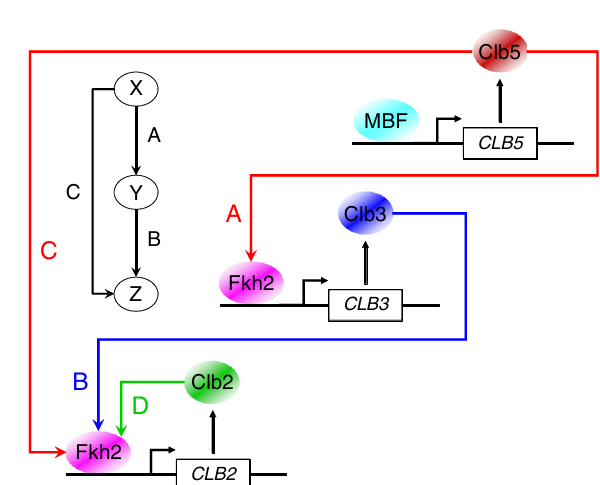
Fig. 6 Model for the transcriptional regulation of the mitotic Clb cascade. A coherent type 1 feed-forward loop may activate CLB genes. Our data indicate a linear activation of Clb cyclins via the Fkh2 transcription factor: Clb5/Cdk1 promotes CLB3 transcription ( arrow A ), Clb3/Cdk1 promotes CLB2 transcription ( arrow B ) together with Clb5/Cdk1 ( arrow C ), and Clb2/Cdk1 promotes CLB2 transcrip- tion by a positive feedback loop ( arrow D ). For the sake of clarity, Cdk1 subunit has been omitted. Arrows represent activating